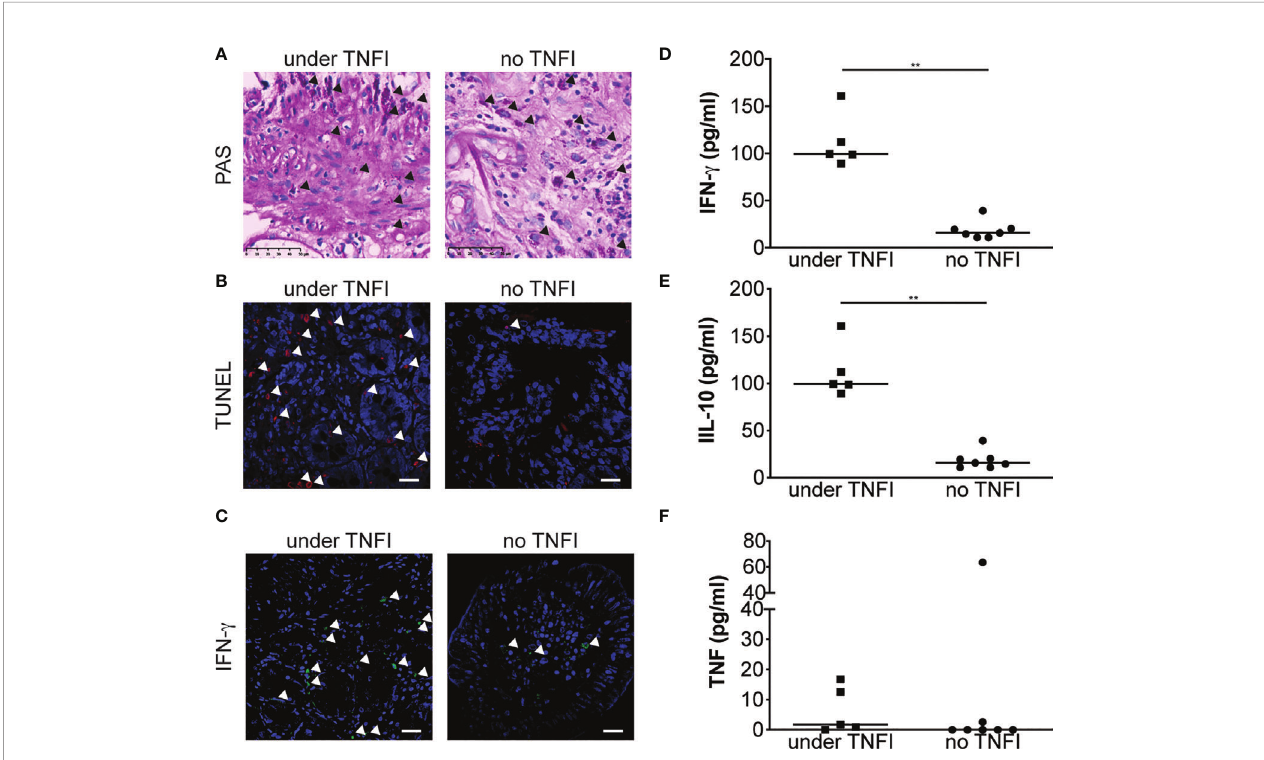
FIGURE 4 | TNFI increase apoptosis in duodenal tissue and local and systemic IFN- g expression. (A) Duodenal biopsy specimen from patients diagnosed under TNFI treatment (left) or not (right) were stained with PAS. Arrows indicate PAS-positive cells (original magni fi cation × 250). (B) Cell apoptosis on duodenal biopsy specimen was assessed by TUNEL assay and observed by confocal microscopy. Representative images are shown. Nuclei are visualized in blue after DAPI staining and TUNEL-positive cells (arrows) appear in red, scale bar = 20 m m. (C) IFN- g expression was evaluated by immunohisto fl uorescence staining and observed by confocal microscopy. Representative images are shown. Nuclei are visualized in blue after DAPI staining and IFN- g -positive cells (arrows) appear in green, scale bar = 20 m m. IFN- g (D) , IL-10 (E) and TNF (F) were measured by ELISA in the sera from patients diagnosed under TNFI treatment (square) or not (circle). ** P < 0.01 by Mann-Whitney U